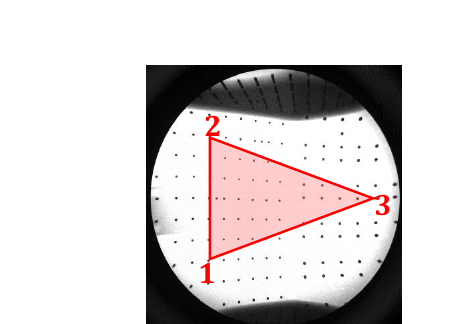
Figure 9. Imaging mechanism and sample of successive images